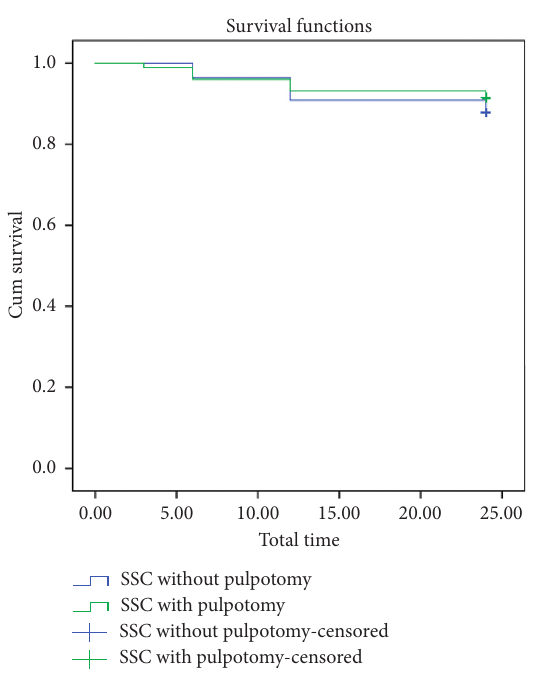
Figure 4: Kaplan–Meier survival plot for stainless-steel crowns with and without pulpotomy.